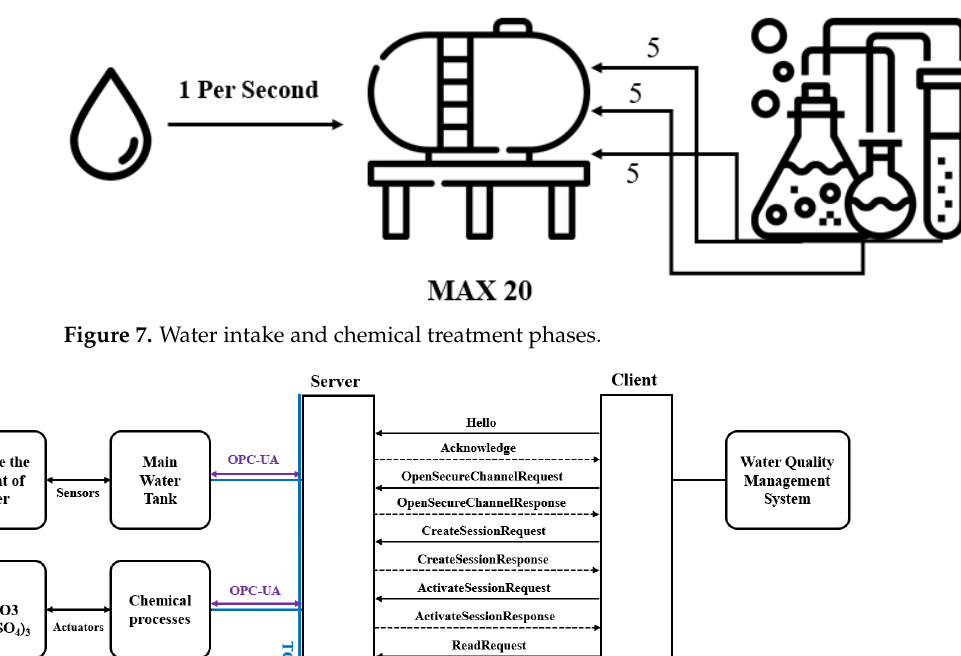
Table 10. OPC UA open-source implementation list.